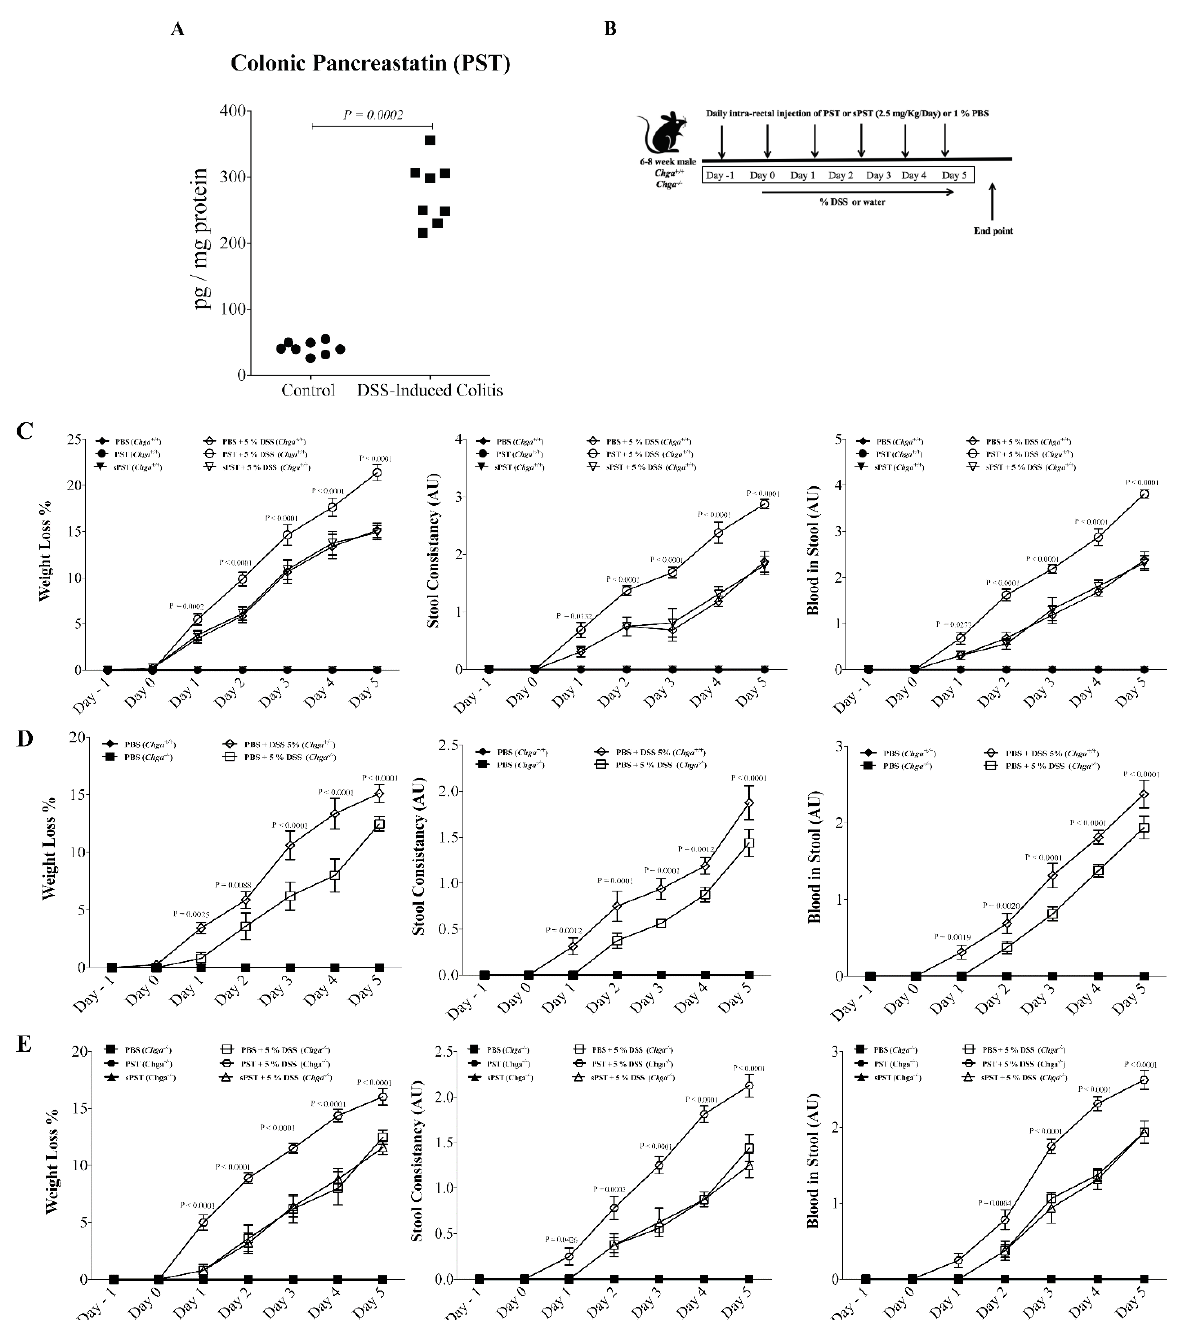
Figure 2. Pancreastatin (PST) aggravates the onset and severity of dextran sulfate sodium (DSS)-induced colitis. C57BL/6 background wild-type ( Chga +/+ ) and CHGA-knockout mice ( Chga −/− ) were given 5% DSS solution in their drinking water for five days to induce colitis. Control mice received water without DSS. PST or scrambled peptide (sPST) (2.5 mg/kg/day, intrarectal) and 1% phosphate buffer saline (1% PBS) treatment started one-day before induction of colitis. ( A ) Colonic protein expression of PST in colitic Chga +/+ mice. ( B ) Illustration depicting the experimental design. ( C ) Weight loss per- centage, stool consistency, and blood in the stool of colitic Chga +/+ treated with PST, sPST or 1% PBS . ( D ) Weight-loss percentage, stool consistency, and blood in the stool of colitic Chga −/− (Previously published [11]). ( E ) Weight-loss percent- age, stool consistency, and blood in the stool of colitic Chga −/− treated with PST, sPST or 1% PBS. AU = arbitrary unit. Values are shown as the mean ± SEM, n = 8–10 mice/group and the p -value was adjusted at 0.05. Mann–Whitney U test was used to compare the PST level in non-colitic and colitic Chga +/+ mice. Two-way ANOVA, followed by multiple comparison tests, was applied to compare the markers in the different groups.